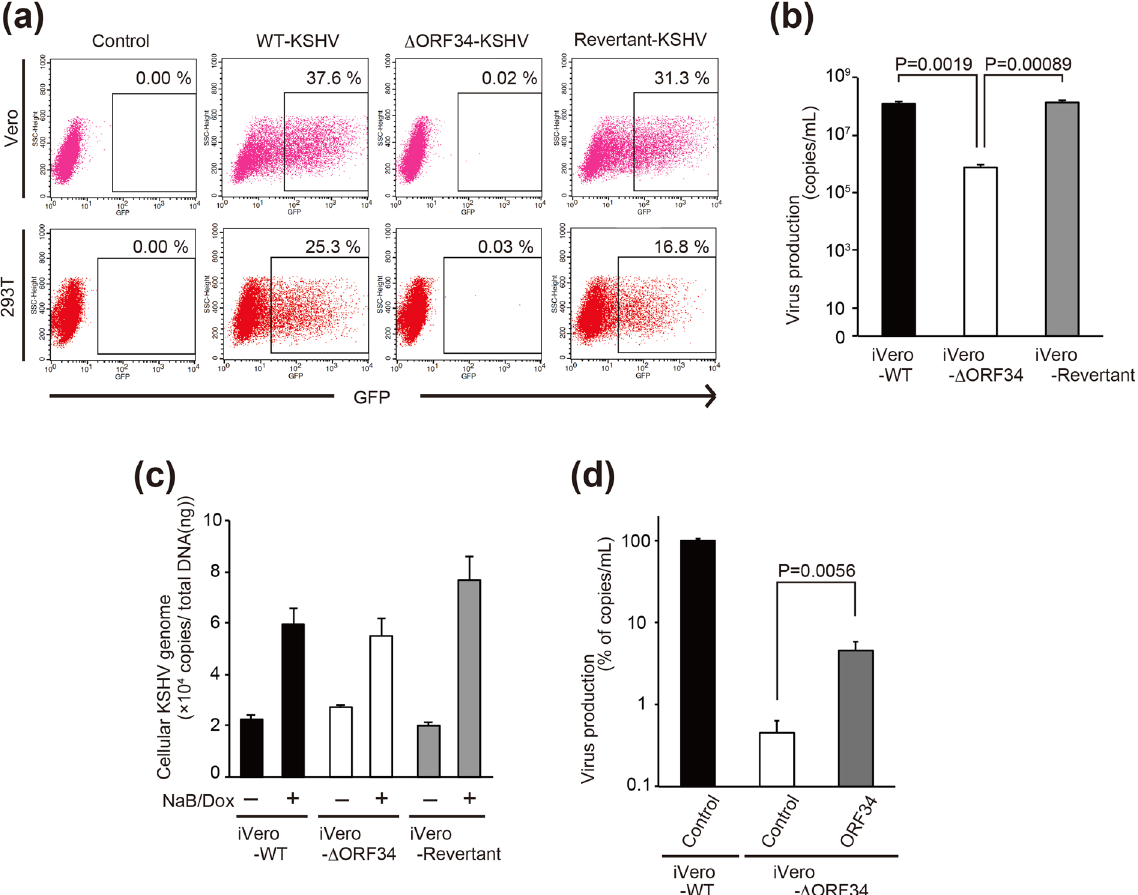
Figure 2. ORF34 is essential for virus production but not DNA replication of KSHV. ( a ) The effects of ORF34 deficiency on recombinant KSHV production. Each iVero cell line (iVero-WT, iVero- Δ ORF34, or iVero- Revertant) were treated with Dox and NaB to induce the lytic-cycle and viral production, and cultured media was harvested after 96 h. Viral precipitates were inoculated onto cells (Vero and 293T) and infection with each KSHV was carried out for 48 h. GFP positive cells were analyzed by flow-cytometer to determine the infectivity of the recombinant viruses. The forward scatter/side scatter plots and gates of Fig. 2a are shown in Supplementary Fig. S2. ( b ) Virus production in iVero-WT, iVero- Δ ORF34, iVero-Revertant. Each iVero cell line was cultured for 48 h with medium containing of NaB and Dox. KSHV DNA were purified from capsidated KSHV virions in culture supernatants, and KSHV genome copies were determined by real-time PCR. ( c ) KSHV DNA replication in iVero-WT, iVero- Δ ORF34, and iVero-Revertant cells. The iVero cells were cultured for 48 h with medium containing of NaB and Dox. Cellular genome containing KSHV genome DNA were purified from each cell lines. KSHV genome copies were determined by real-time PCR and normalized by the total DNA amount. ( d ) Rescue of virus production in iVero- Δ ORF34 cells by exogenous ORF34 expression. The iVero-WT or iVero- Δ ORF34 cells were transfected with control plasmid or ORF34 plasmids. After 2 days, transfected cells were cultured with NaB and Dox-containing medium for 3 days, and culture supernatant containing virus was harvested. The KSHV genome was quantified by real-time PCR. ( b – d ) Three or four independent samples were evaluated by real-time PCR. The error bars indicate standard